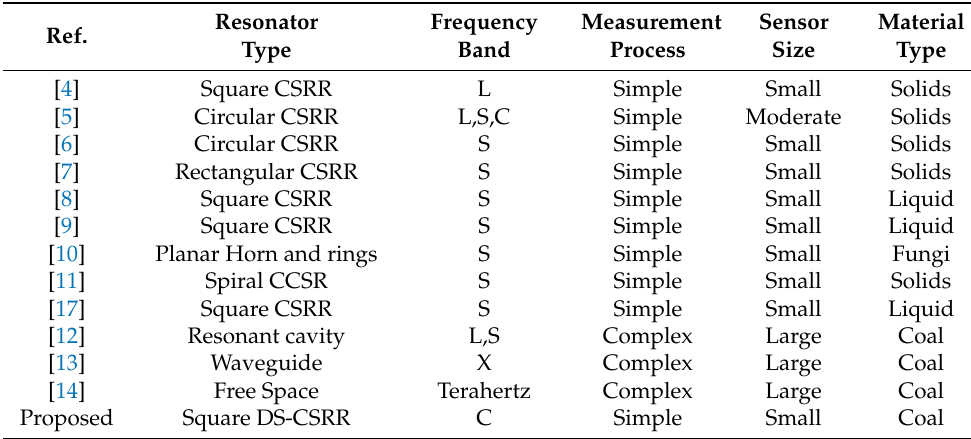
Table 1. Dielectric Properties Measurement techniques.